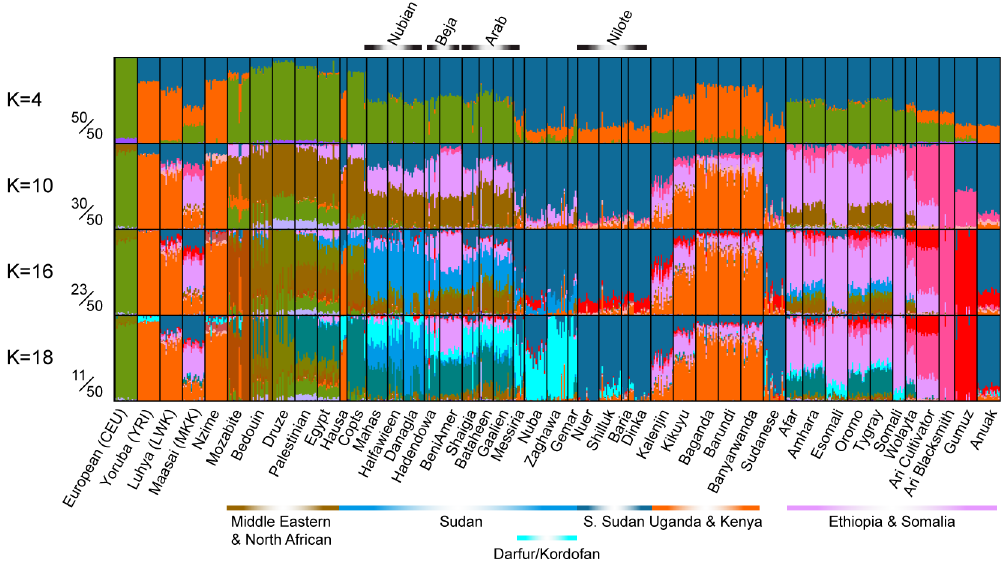
Fig 2. Inferred admixture fractions [51] for different choices of number of clusters. Four different numbersof clusters are displayed.The fractions on the left show the fraction of 50 replicateanalysesthat support of the most common and displayedmode [52]. Populationsthat did not contribute to the African variation were removedfrom this figure. See S3 Fig for the full range of populations and additionalK. The bars on top represent the ethnic group, the bars on the bottom